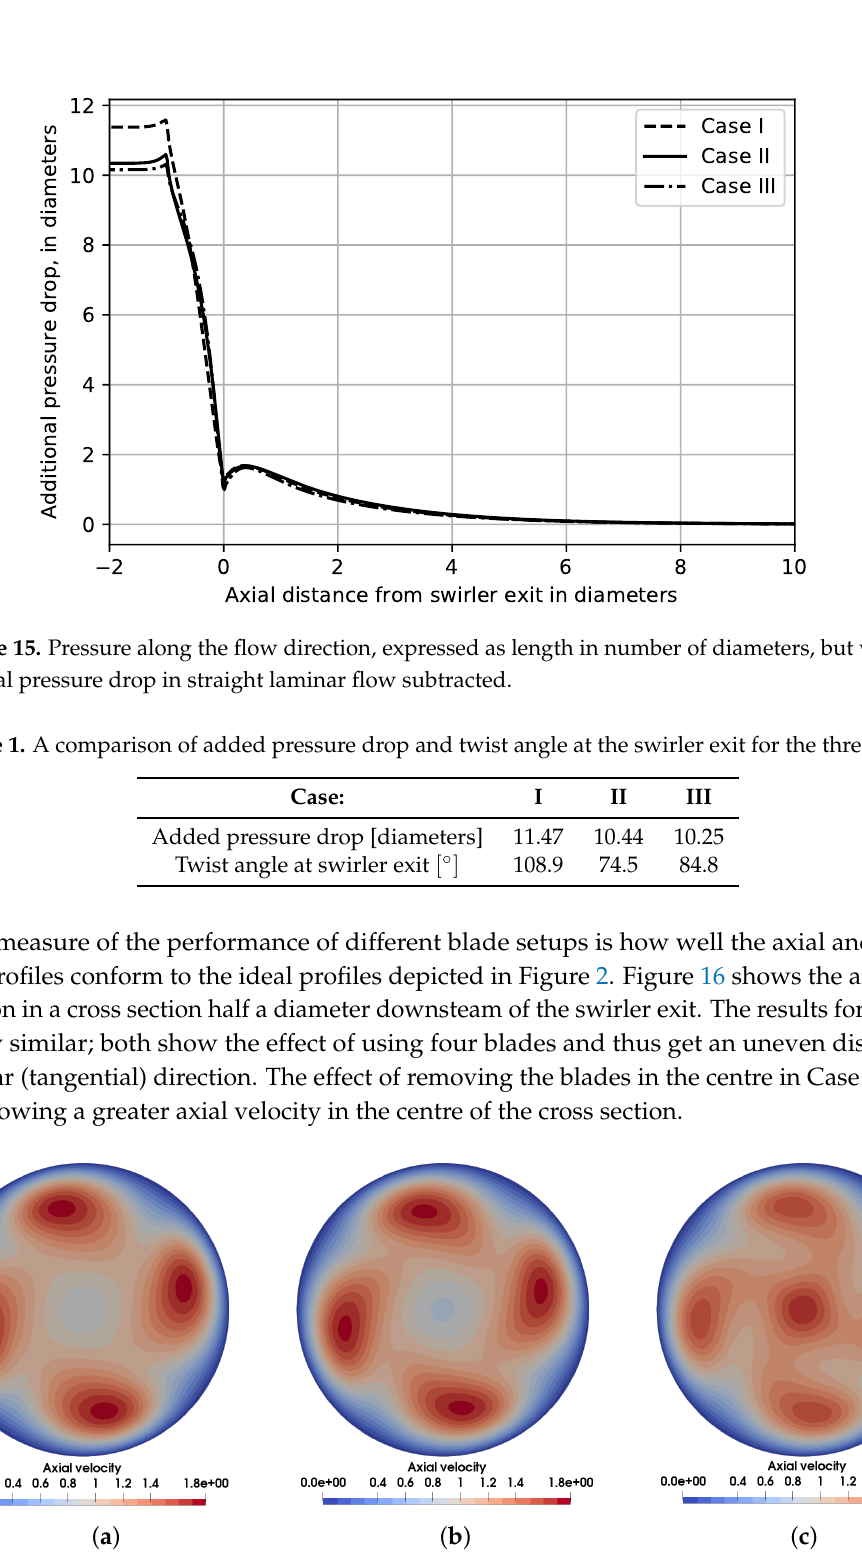
Figure 16. Axial velocity in m/s in a cross section, 0.5 diameters downstream of the swirler exit, ( a ) Case I (left); ( b ) Case II (center) and ( c ) Case III